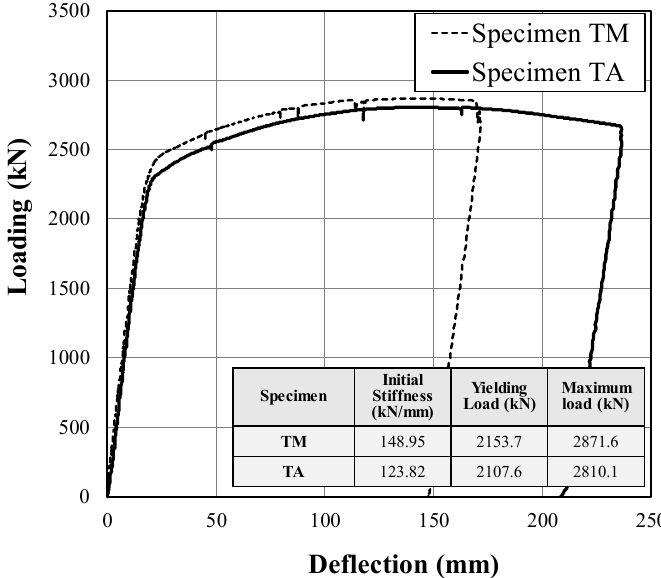
Figure 9. Load–deflection curves of specimens. Specimen TM: SM490TCM for web; specimen TA: SM490A for web.